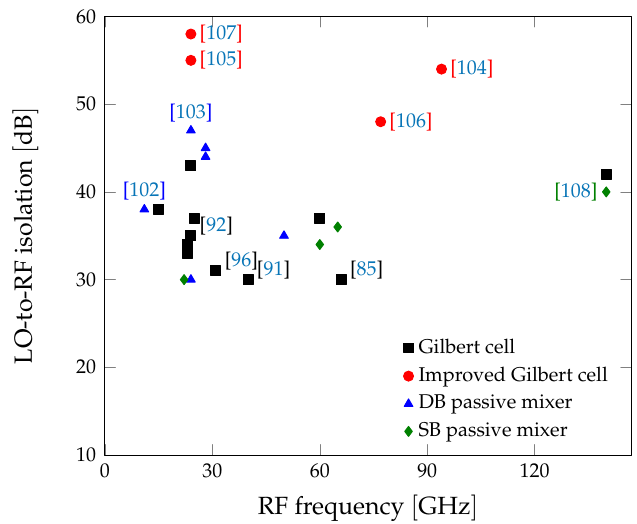
Figure 23. LO-to-RF isolation versus frequency.